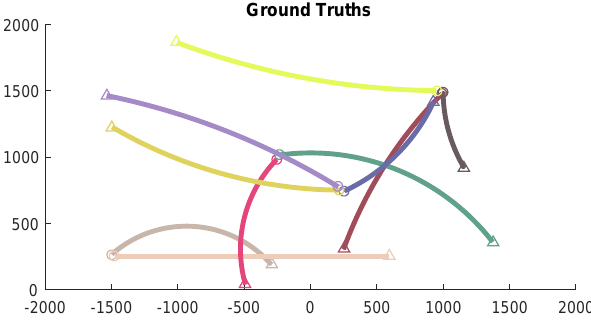
Figure 2. Ground truth of the considered